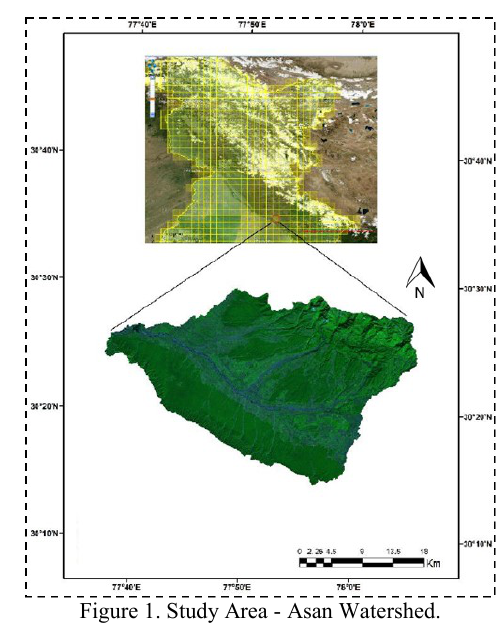
Figure 1. Study Area - Asan